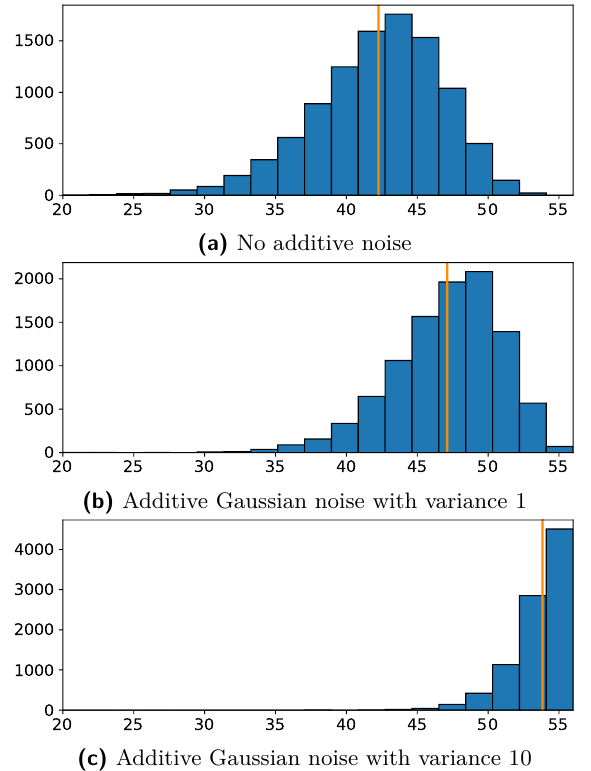
Figure 17: Histograms for security levels of 10k simulated traces, one attack trace per key. Security levels are plotted on the x-axis, number of keys per bin on the y-axis. The mean security level is marked by an orange